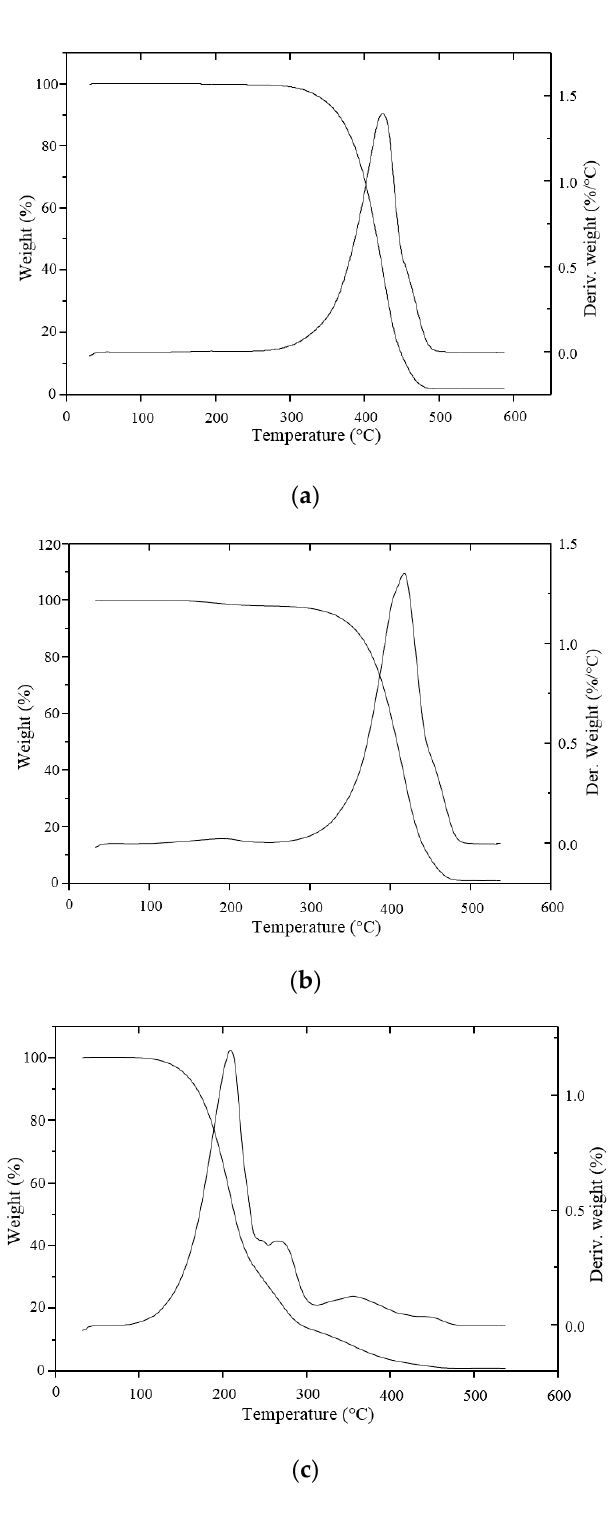
Figure 6. Thermogravimetry and derived thermogravimetry curves of oils of B. glabra extracted with hexane at room temperature ( a ) to degummed oil with H 3 PO 4 ( b ) and of methyl biodiesel of degummed oil ( c ).